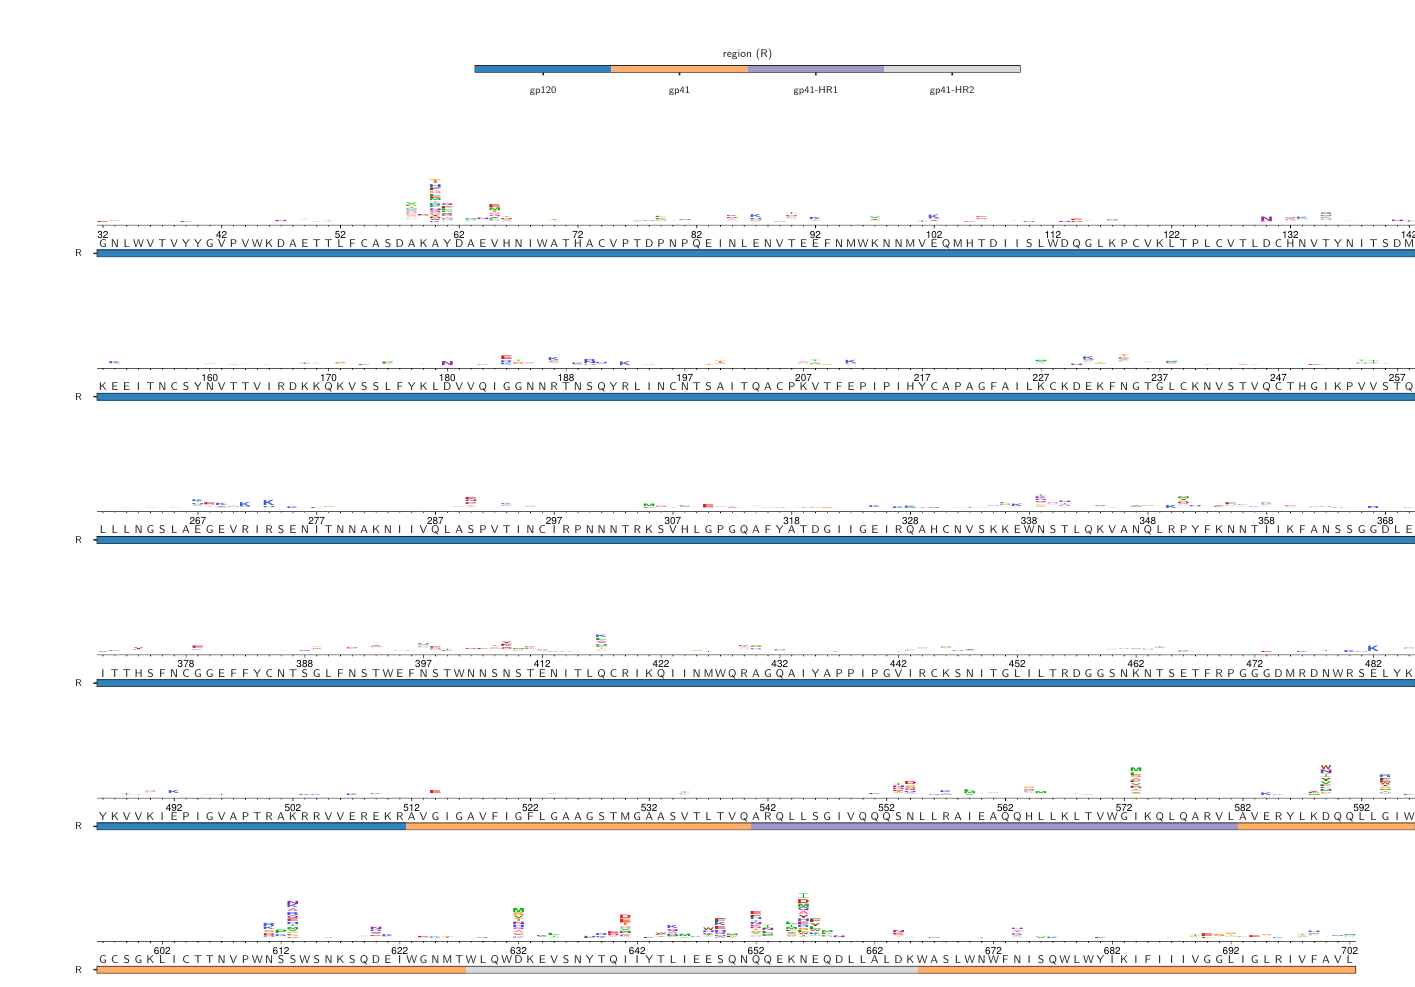
Figure 4. S mut / wt values of amino acids enriched during 293T hu infection. BF520 Env wild-type amino acid identities are shown below the axes for residues 32–702. Logoplots above the axes indicate mutants that were enriched relative to wild-type residues (S mut / wt > 0) following infection of 293T hu cells in our deep mutational scanning (DMS). The height of each letter is proportional to the S mut / wt value for that amino acid mutant following 293T hu infection, averaged over both replicate infections. Site numbers correspond to HXB2 numbering. The underlay bar indicates Env